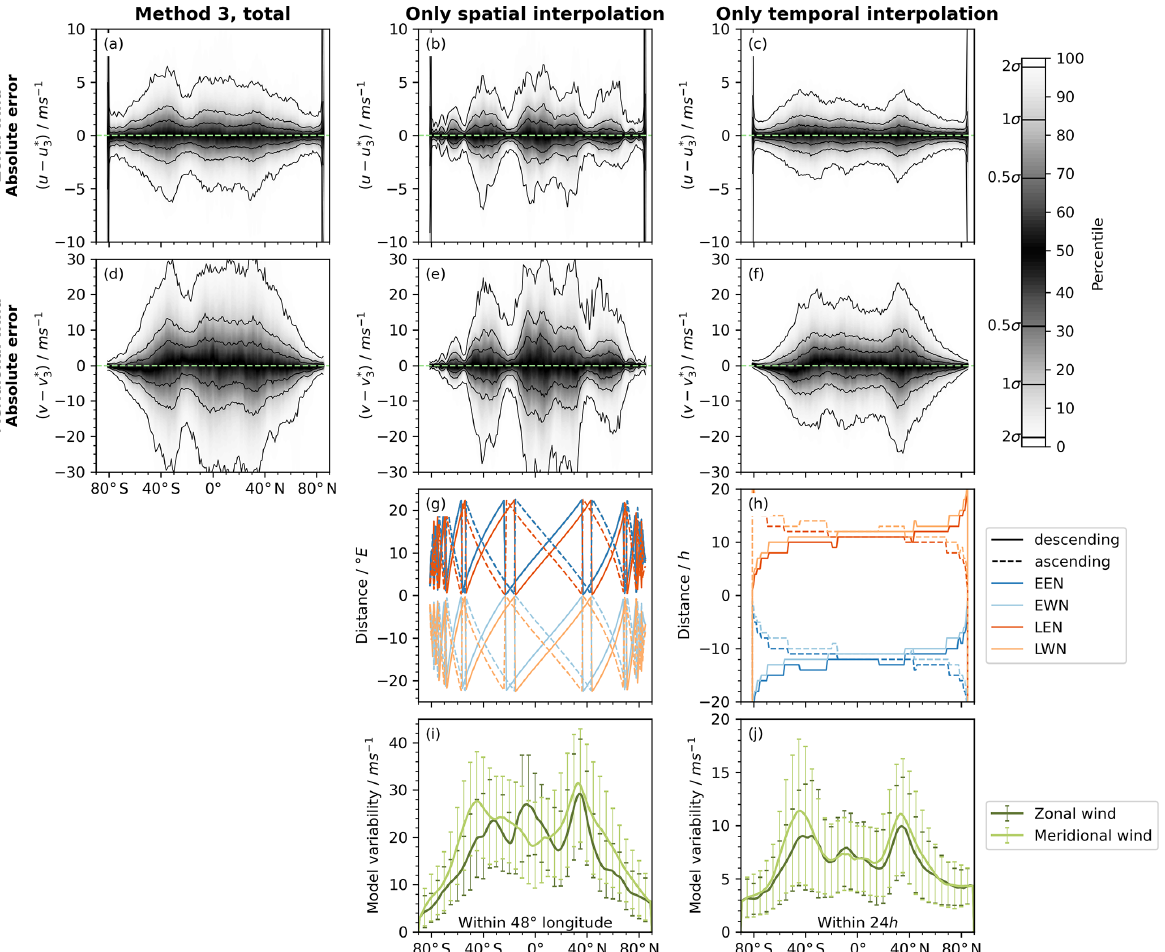
Figure 8. Influence of spatial and temporal interpolation on the total error statistics of Method 3. Panels (a) and (d) are a copy of Fig. 7c and i. The first two rows show the error statistics for zonal and meridional wind. In the third row, the spatial (g) and temporal (h) distance to the four nearest neighbours used for interpolation is plotted. The bottom row depicts the mean difference between maximal and minimal wind speed within 48 ◦ longitude (i) and 24h (j) derived from ERA5 data. Data from the whole month of January is used for this variability